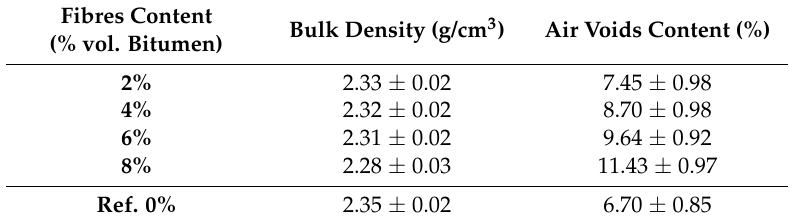
Table 3. Bulk density and air void content of asphalt mixtures (Average ± Stand. Deviation).